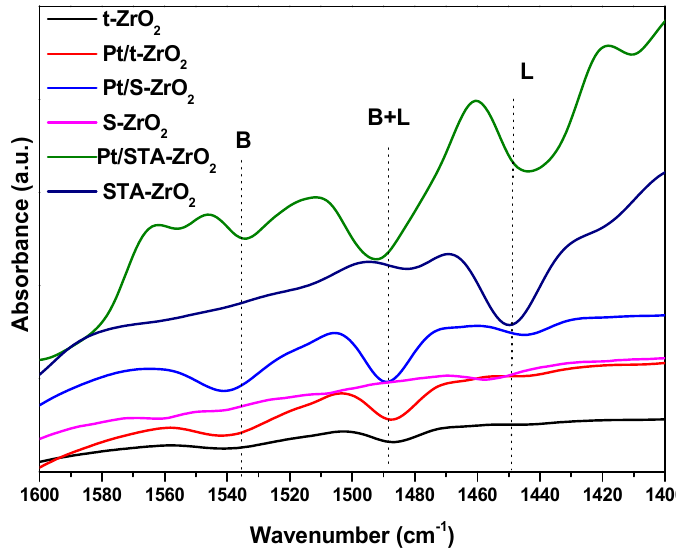
Figure 3. Pyridine FTIR spectra profiles of ZrO 2 -based catalysts.